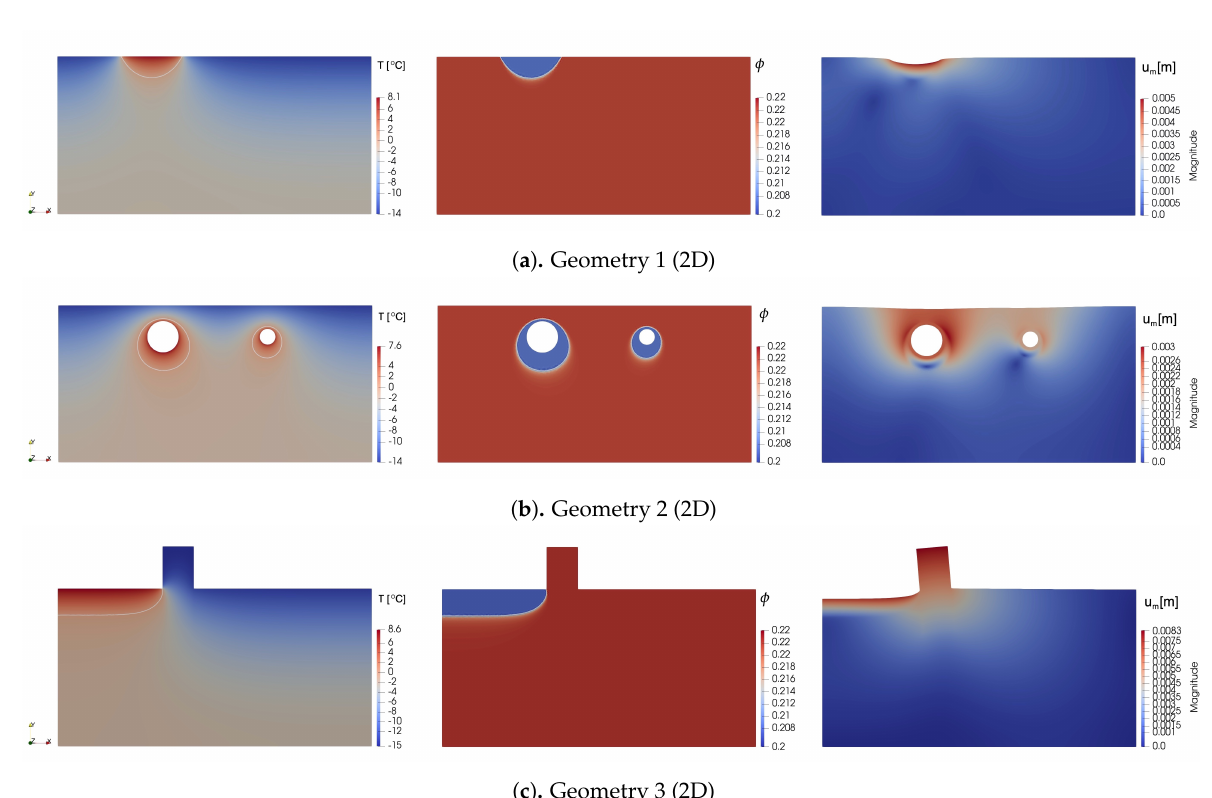
Figure 6. Test 1 for a two-dimensional problem. Temperature, porosity, and displacement fields at the final time (from left to right).